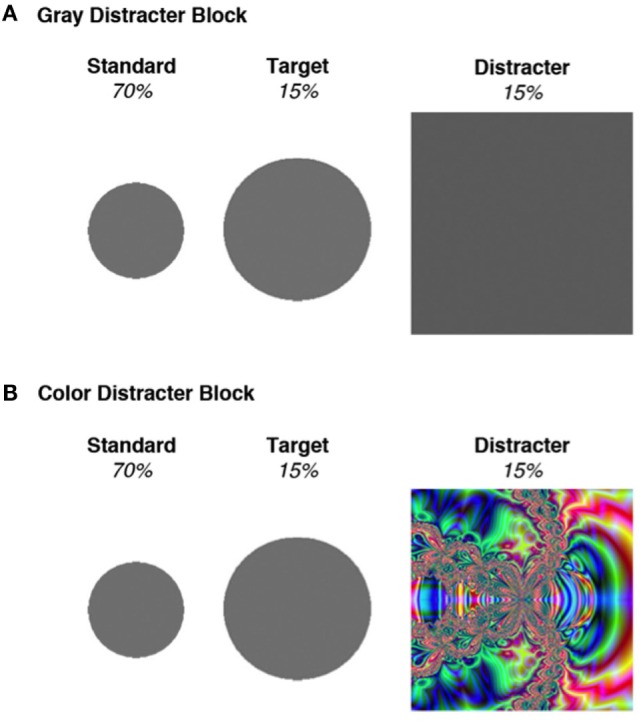
Stimuli used in the two blocks of the oddball task. (A) All stimuli in the gray distracter block comprised an identical gray color. (B) Standards and targets in the color distracter block were identical to those presented in the gray distracter block, but the distracters consisted of unique colorful fractal designs. Adapted from Kaufman et al. (36).